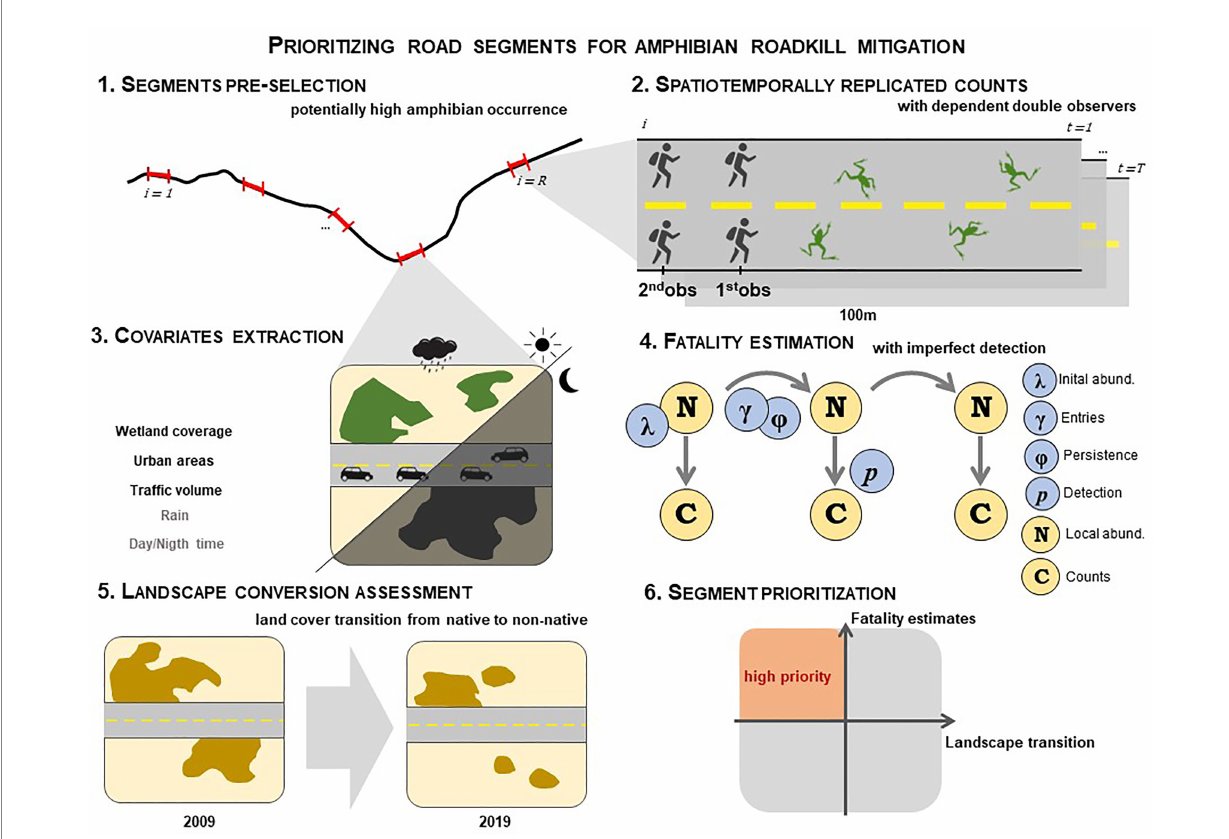
FIGURE 1 Framework to spatially prioritize road segments for amphibian roadkill mitigation based on fatality estimation and landscape stability. (1) R road sites of 100 m length, where amphibian occurrence is expected to be higher, are pre-selected for sampling; (2) Each site i is surveyed T times searching for carcasses using a dependent double-observer protocol; (3) Covariates hypothesized to influence spatial and temporal variation in roadkill rates and persistence are compiled (black and gray letters indicate spatial and temporal covariates respectively); (4) Carcass counts C and covariates are fitted under a hierarchical open N-mixture model to explicitly estimate roadkill rates. Dynamics in the population of carcasses N is modelled as a result of two processes, entries and persistence. A roadkill rate is derived from the entry parameter γ ; (5) Landscape stability is assessed by measuring the transition rates from native to non-native covers; and (6) Priority segments for mitigation are defined based on high fatality rates and low landscape transition